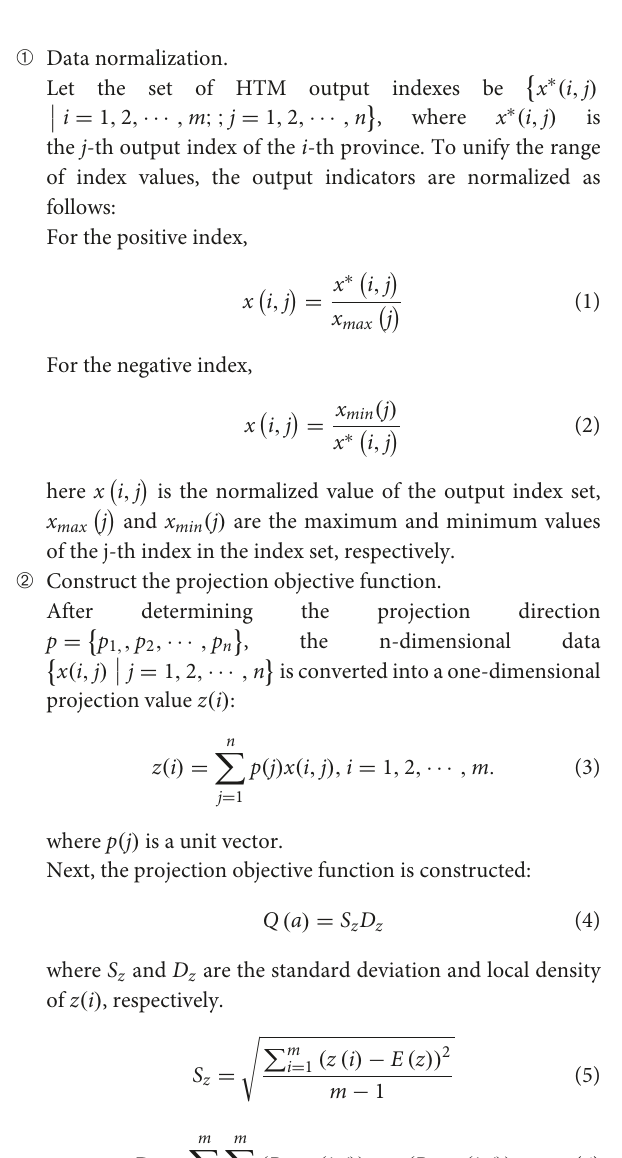
FIGURE1 Research